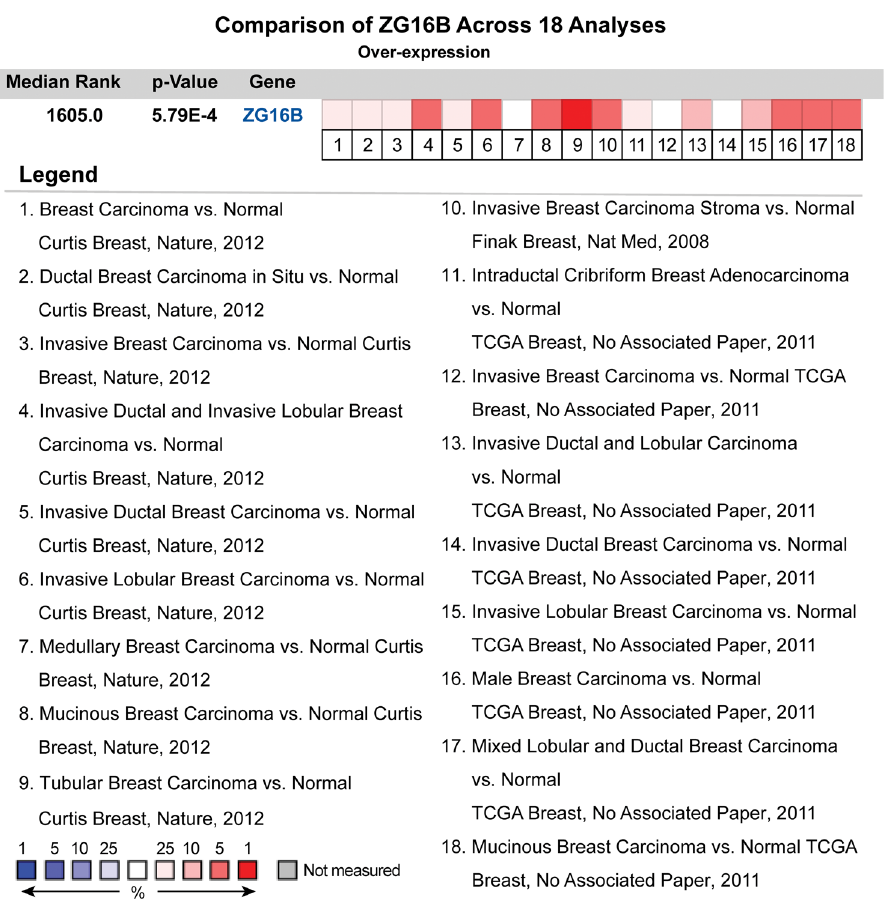
Figure 3: The pooled meta - analysis of gene expression pro fi ling for ZG16B gene across 18 analysis. The color of the grid represented if the gene expressed higher ( red ) or lower ( blue ) . The color depth of the grid depended on the median gene rank percentiles. The rank of ZG16B was the median rank across each of the analyses. The p - value of ZG16B was for the median - ranked